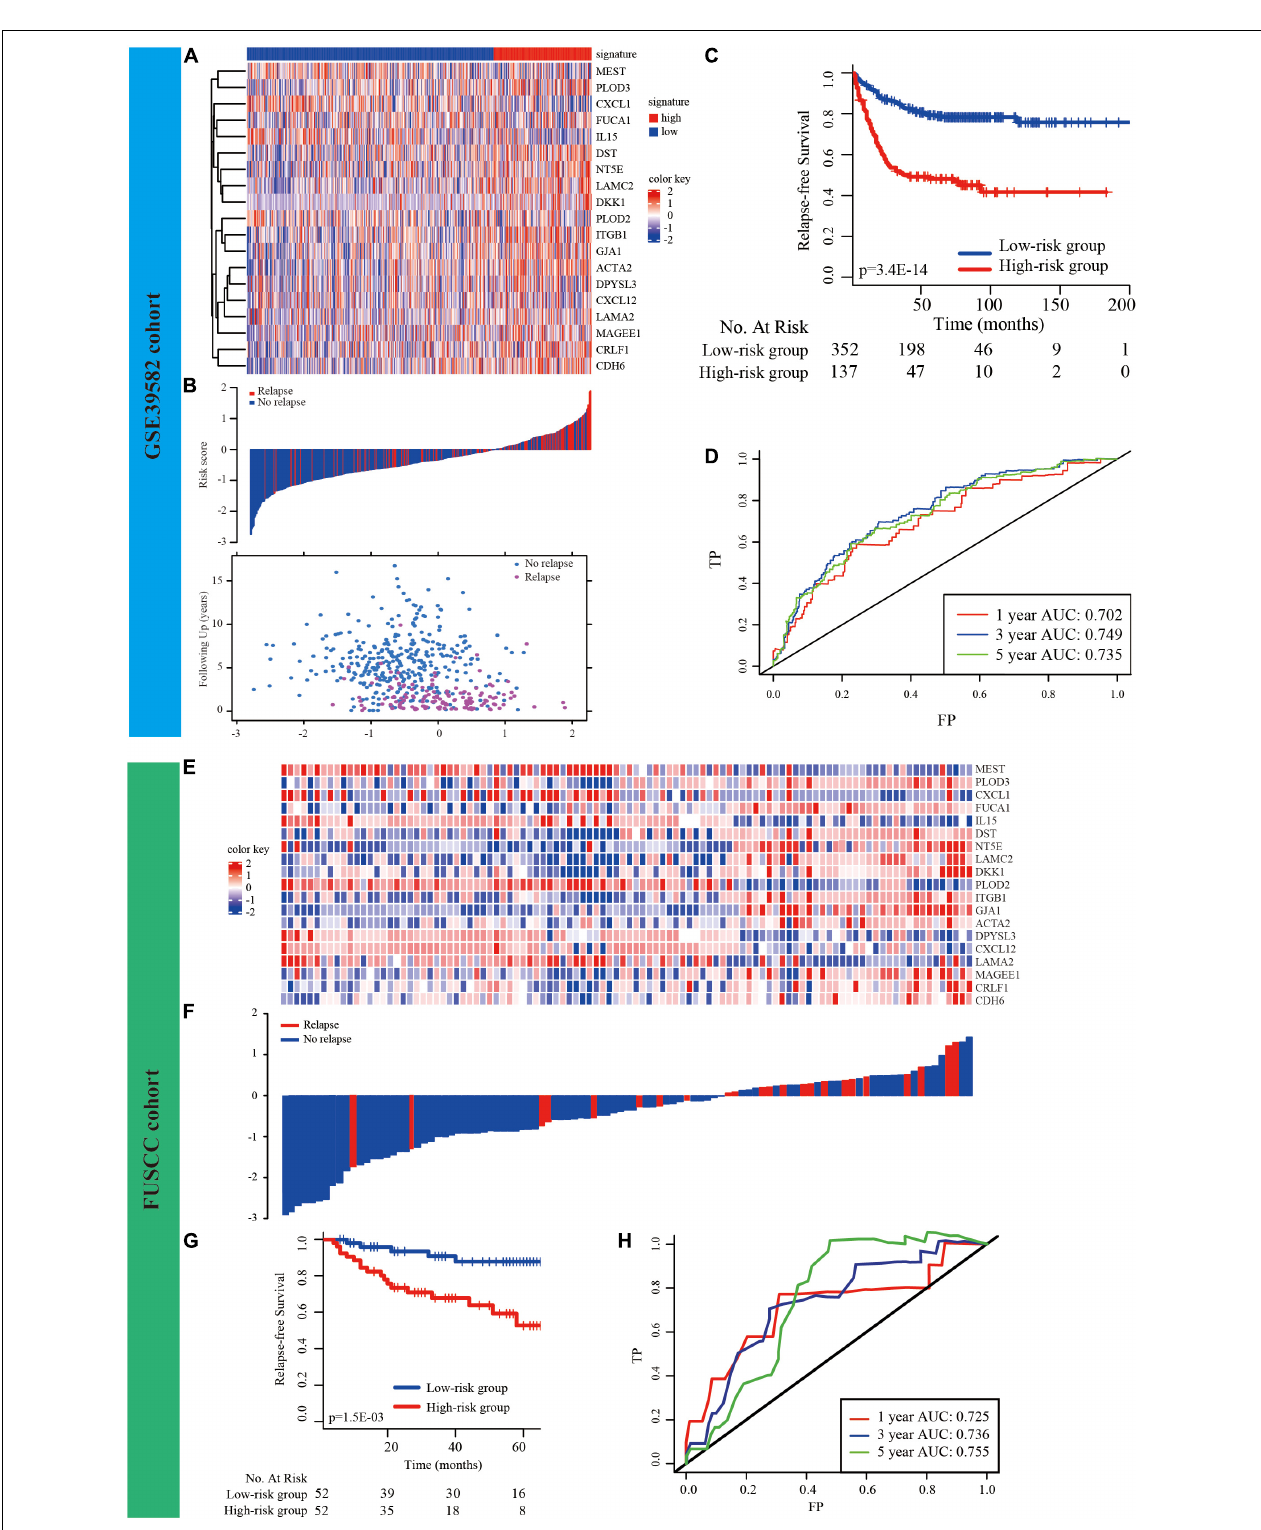
FIGURE 2 | Development and validation of prognostic EMT-related gene signature. (A) The expression of the EMT-related genes between low − and high-risk groups was shown in the heatmap. (B) Relationship between the survival status/risk score rank and survival time (years)/risk score rank. (C) K–M survival analysis of high − and low-risk groups. (D) Time-dependent ROC curve for RFS. The AUC was assessed at 1 − , 3 − , and 5-year. (E–H) Validation of the prognostic EMT-related gene signature in FUSCC cohort.